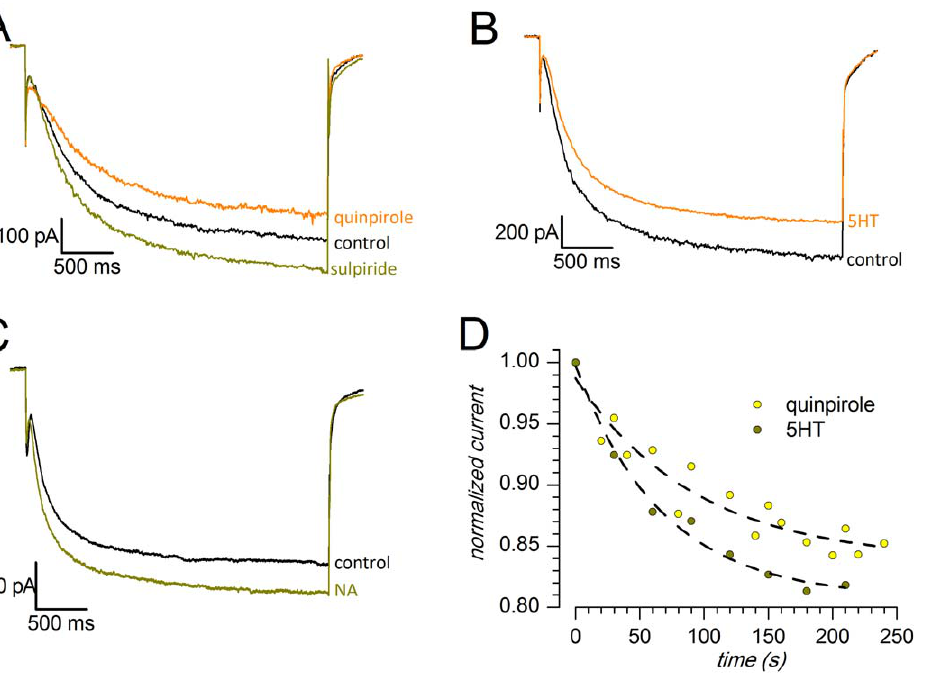
Figure 8. Sample tracings showing the effect of different neurotransmitters on the h-current; responses to hyperpolarizations to 2 130 mV from a holding potential of 2 40 mV; perforated patches, 37 6 C. The external saline included TTX, 4AP, TEA and Ba2 + . A: Effects of the D2 agonist quinpirole (30 m M) and of the D2 antagonist sulpiride (20 m M); note that in the presence of the antagonist the response is greater than controls. B: Effect of 5-HT (100 m M). C: Effect of NA (100 m M). D: Time constant of the development of the effects of quinpirole and 5-HT.